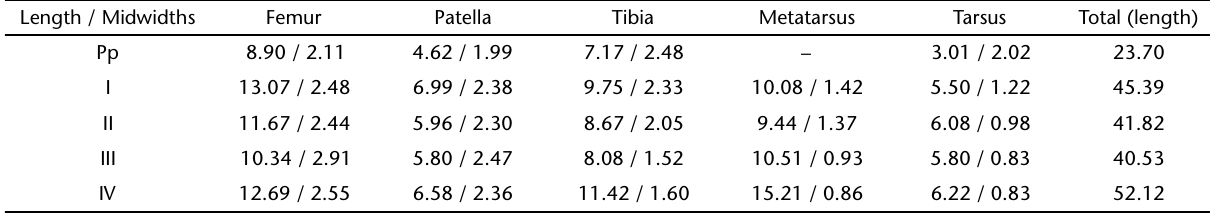
Table V. Vitalius nondescriptus comb. nov. Male MZSP 465161 from Ouro Preto, state of Minas Gerais, Brazil (captive born from female MZSP 465351). Length and midwidths of right legs and palpal segments. Length / Midwidths